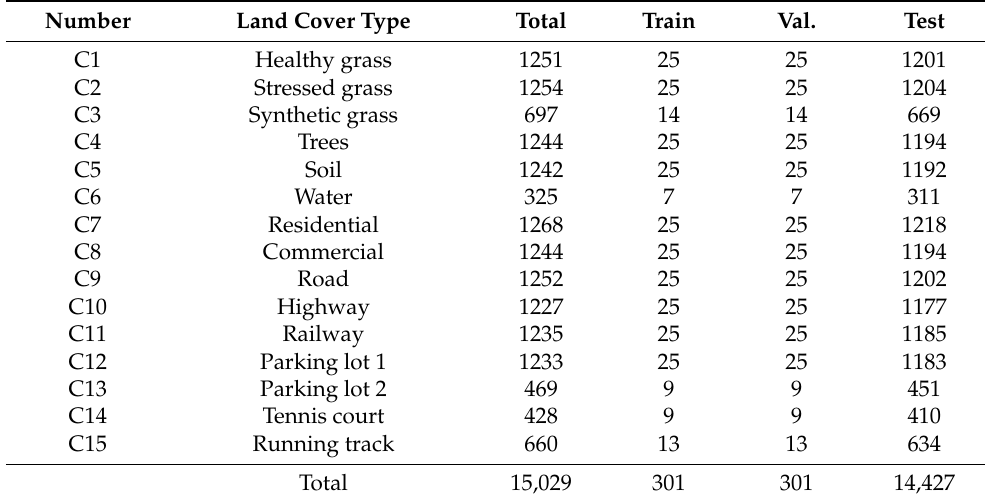
Table 9. The number of total samples, training samples, validation samples, and testing samples for each category of the HS dataset.